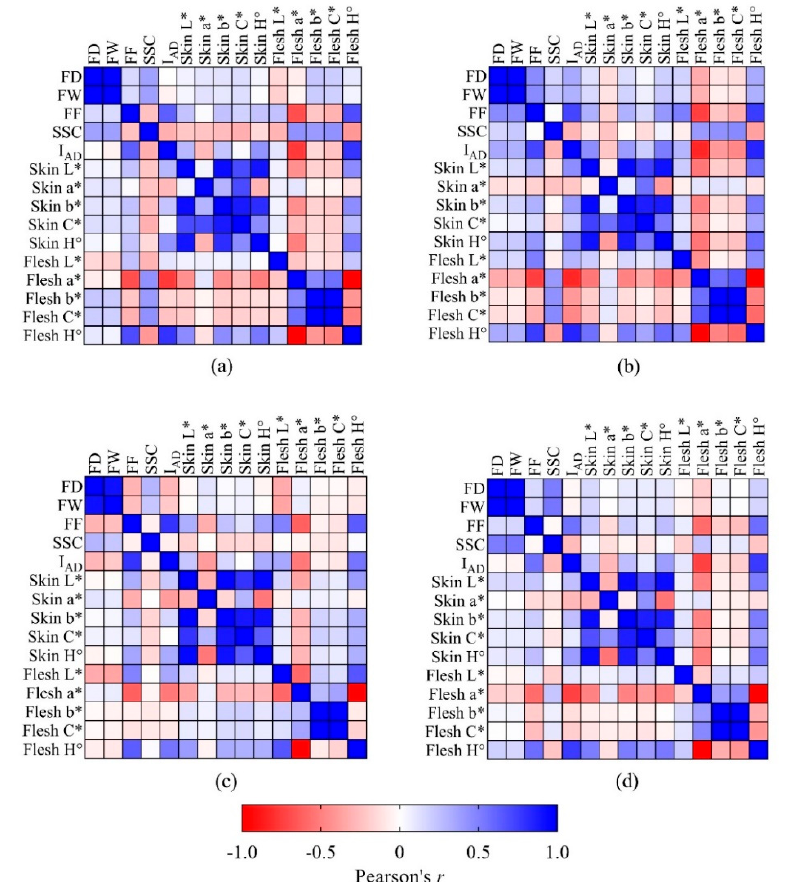
Figure 1. Pearson’s correlation ( r ) heatmap for FD, FW, FF, SSC, I AD and skin and flesh colour attributes (L*, a*, b*, C*, H ◦ ) in fruit of four yellow peach cultivars at harvest ( n = 200). Correlation strength represented on a colour scale, where red represents high negative correlation, blue corresponds to high positive correlation and white is no correlation. ( a ) ‘August Flame’; ( b ) ‘O’Henry’; ( c ) ‘Redhaven’ and ( d ) ‘September